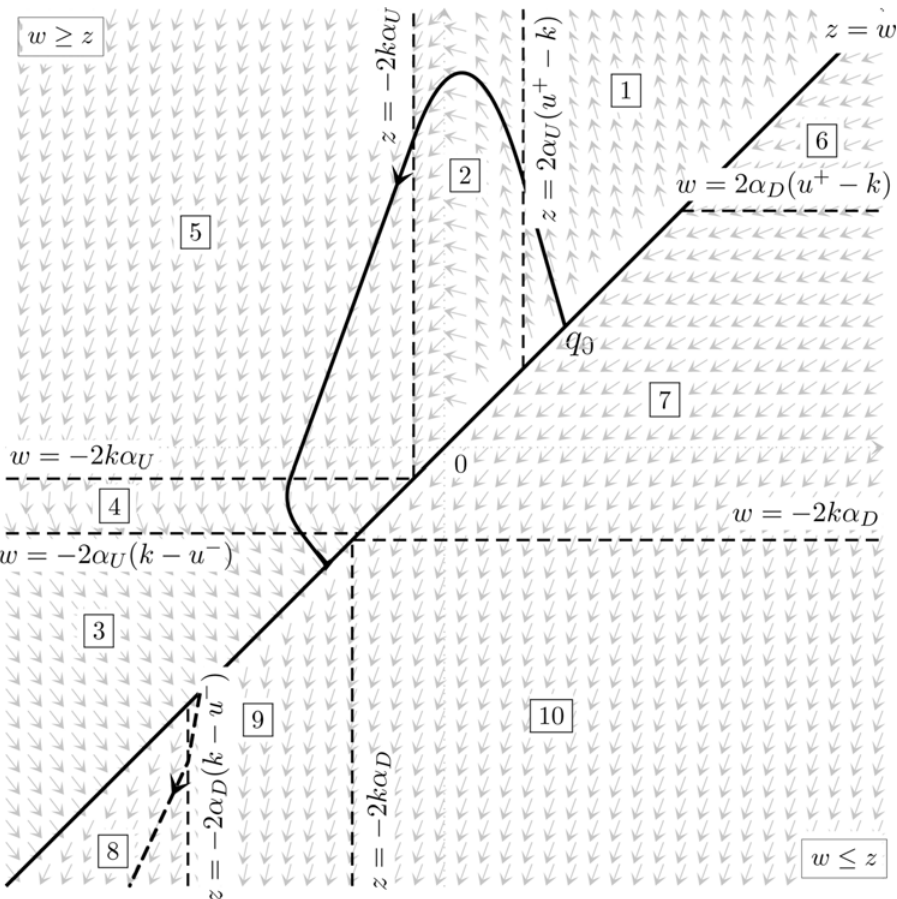
Figure 11. Phase portrait for p 0 $ k in the plane ( z , w ). The bisector ( z = w ) corresponds to the set of velocities equal to zero. The upper and lower semi-plane corresponds to positive and negative angular velocities, respectively. An optimal path starts and ends on this line. This figure illustrates the optimal phase portrait corresponding to the S 2 strategy (for an upward motion). Regions are denoted by boxed numbers and the commutation times correspond to switches between regions. For instance Region 5 corresponds to the inactivation region (i.e., the control signal is zero here). Note that the different strategies illustrated in Figure 10 are easily understood with this phase portrait, since optimal paths may start and end in different regions. The constants k , a U , a D , and u + and u 2 are parameters depending respectively on the mechanical model of the arm, the coefficients involved in our cost function, and the boundary values imposed on the control u .